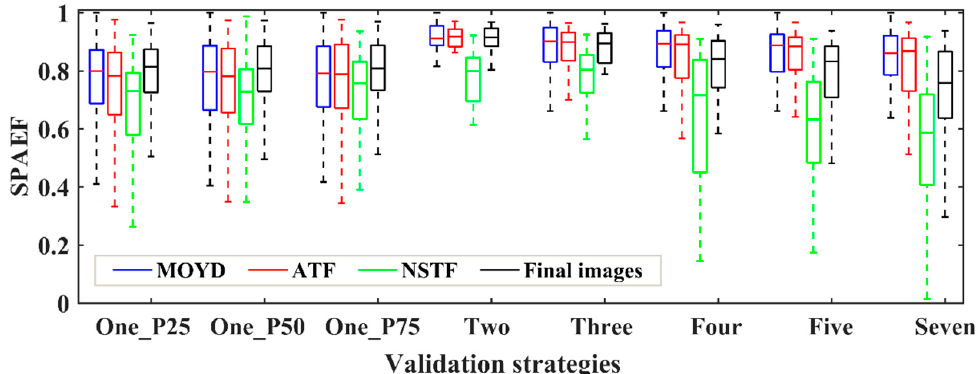
Figure 12. Spatial pattern validation results for the spatial efficiency (SPAEF) of MODY, adjacent temporal filtering (ATF), non-local spatio-temporal filtering (NSTF), and final images.